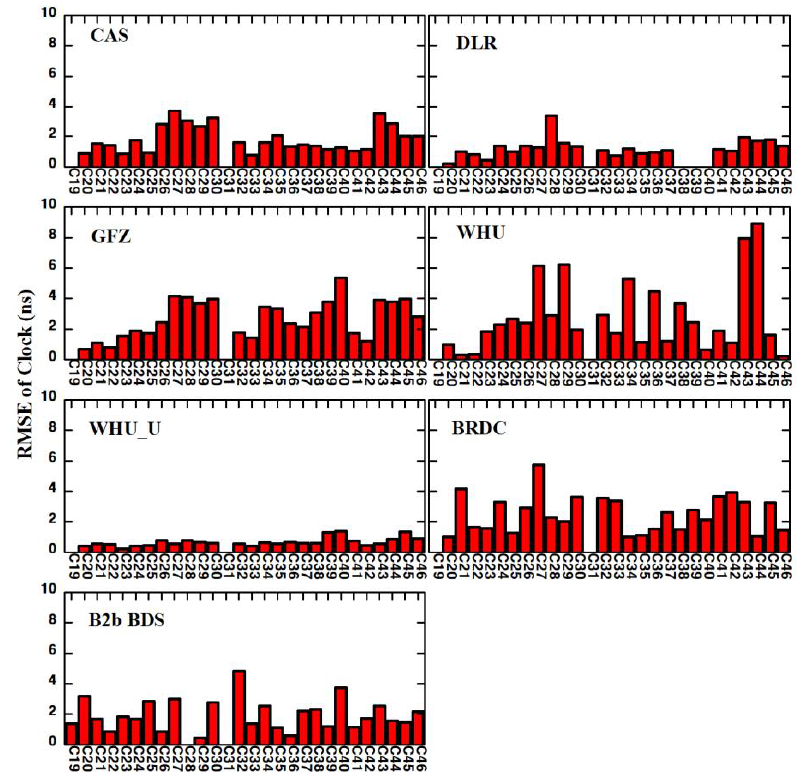
Figure 16. The RMSE of real-time orbit clock errors.